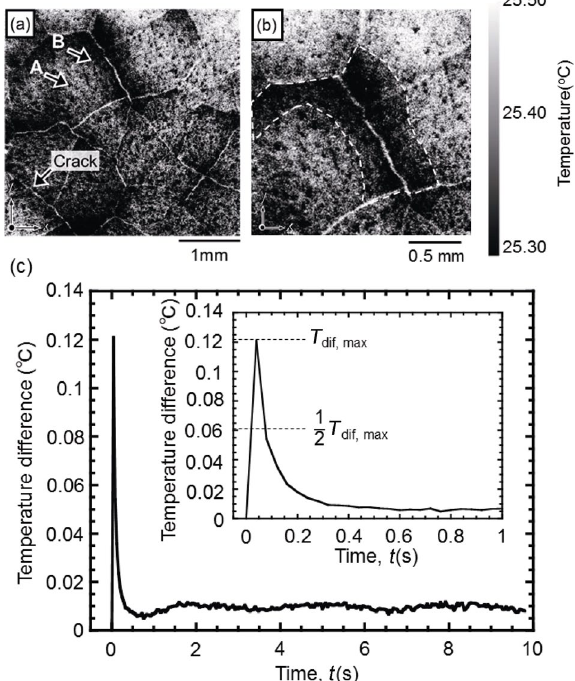
Fig. 5 (a) Typical examples of temperature distribution on surface of EBC; (b) enlarged view of (a); (c) temperature difference approximately in middle of segment and around